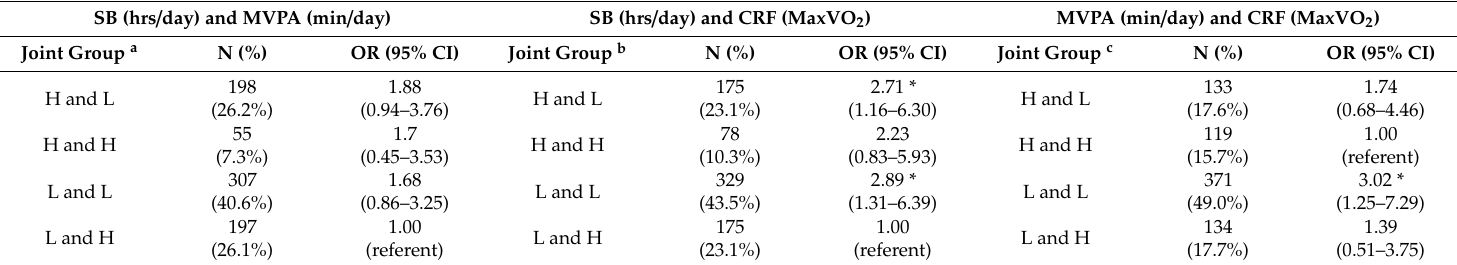
Table 3. Two-Way Combined Associations of SB, MVPA and CRF with Sleep Quality.